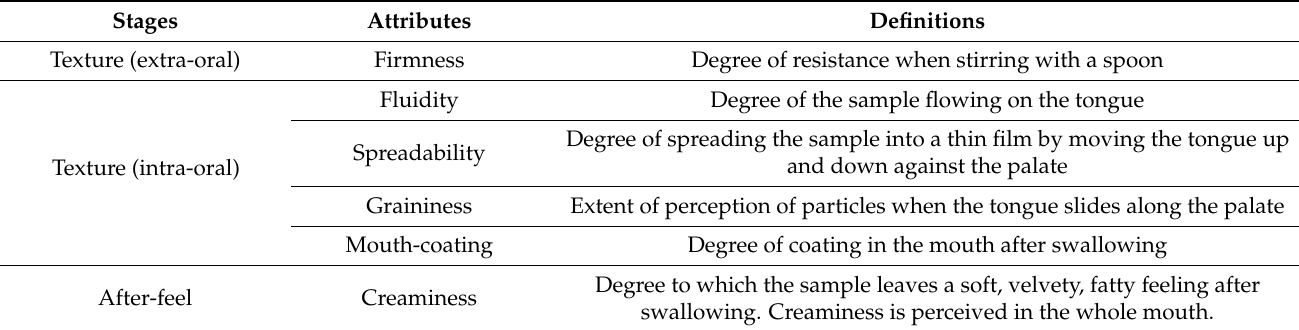
Table 2. Textural attributes and